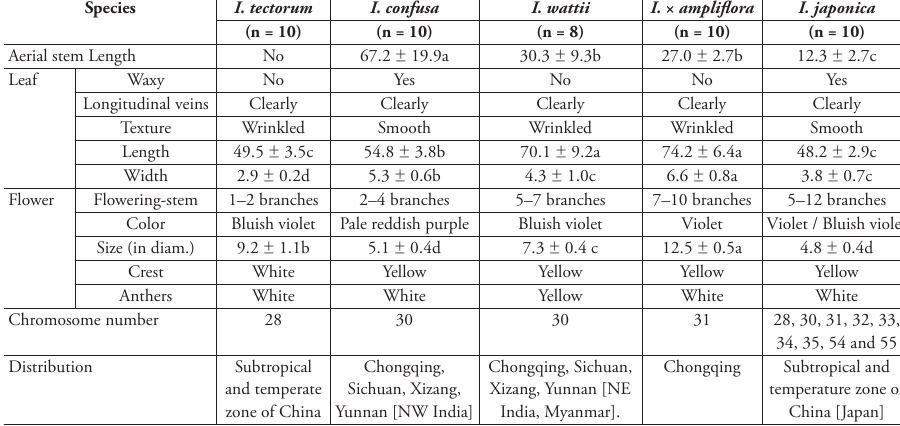
Table 1. Differences between Iris × ampliflora , I. confusa , I. tectorum , I. wattii and I. japonica in the con- servation nursery of Shanghai Botanical Garden.